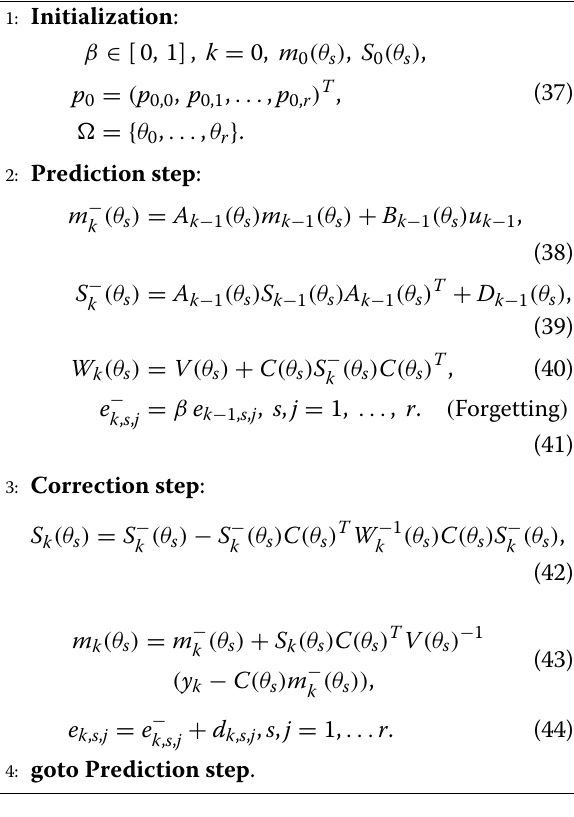
Algorithm 2 Logarithmic odds fault